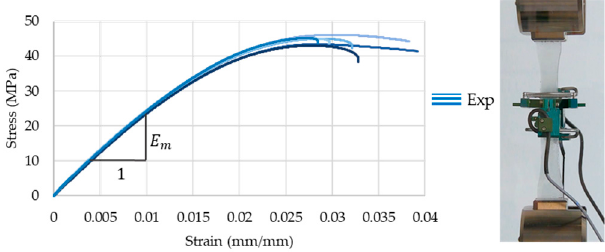
Figure 6. Epoxy tensile tests: stress–strain curves ( left ) and the experiment setup ( right ).